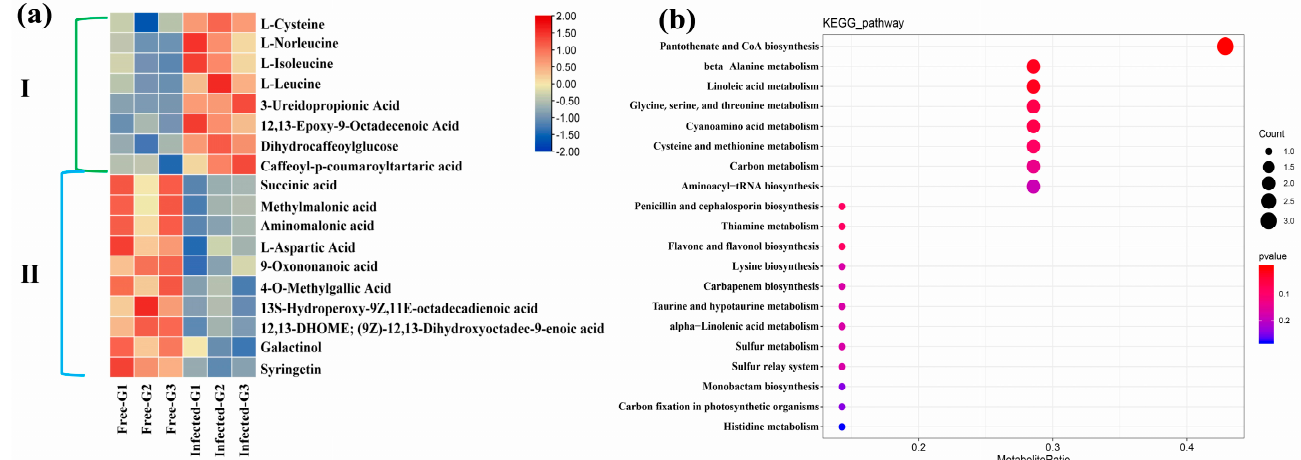
Figure 9. Profiling of differentially expressed metabolites (DEMs) in berries. ( a ) Heatmap of DEMs. I represents the up − regulated metabolites, and II indicates the down − regulated metabolites. ( b ) Top 20 enrichment pathways based on KEGG analysis of the total DEMs between GFabV − infected and − free berries. The size of bubble represents the number of metabolites in the pathway, and the color represents the P value.